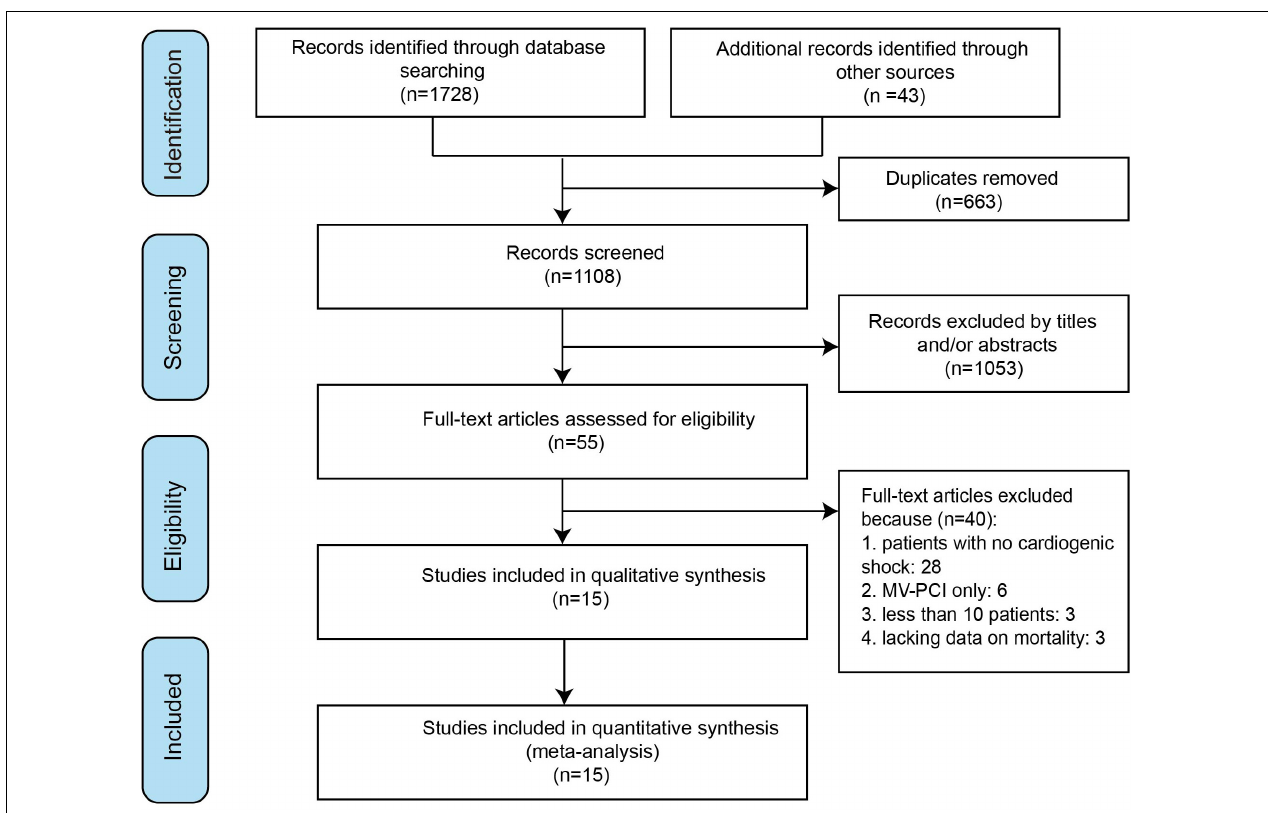
FIGURE 1 | Flowchart for the systematic literature